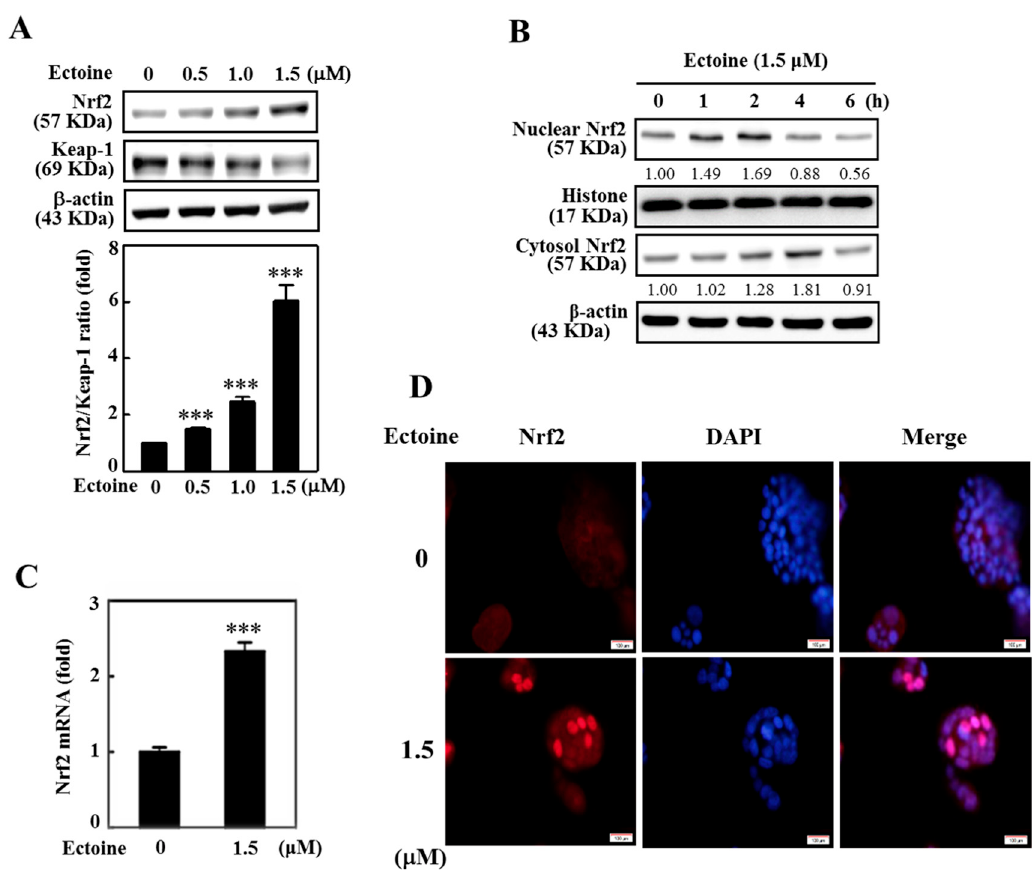
Figure 4. Ectoine upregulated the nuclear translocation of antioxidant marker Nrf2 in HaCaT cells. ( A ) Effect of Ectoine on protein expressions of Nrf2 and Keap-1 in HaCaT cells. Western blot method measured the expressions of Nrf2 and Keap-1 in cells treated with Ectoine (0–1.5 μ M) for 2 h ( B ) Effect of time on the Ectoine mediated nuclear and cytosolic expressions of Nrf2. Cells were exposed to 1.5 μ M Ectoine for different time points and Western blot method measured the expressions of nuclear and cytosolic Nrf2. ( C ) Cells were pre-treated with Ectoine (1.5 μ M, 1 h) followed by the isolation of total mRNA from HaCaT cells. 1 μ g of total mRNA was used to measure the expression of the Nrf2 gene through the RT-PCR method. As an internal control, GAPDH was used. ( D ) Immunofluorescence staining of HaCaT cells. Cells were treated with 1.5 μ M of Ectoine for 2 h and the nuclear localization of Nrf2 were visualized by immunofluorescence method. Cells were stained with DAPI (1 μ g/mL) for 5 min and examined by fluorescence microscopy (scale bar 100 μ m) . Statistical significance was assigned as *** p < 0.001 compared to the untreated control cells.